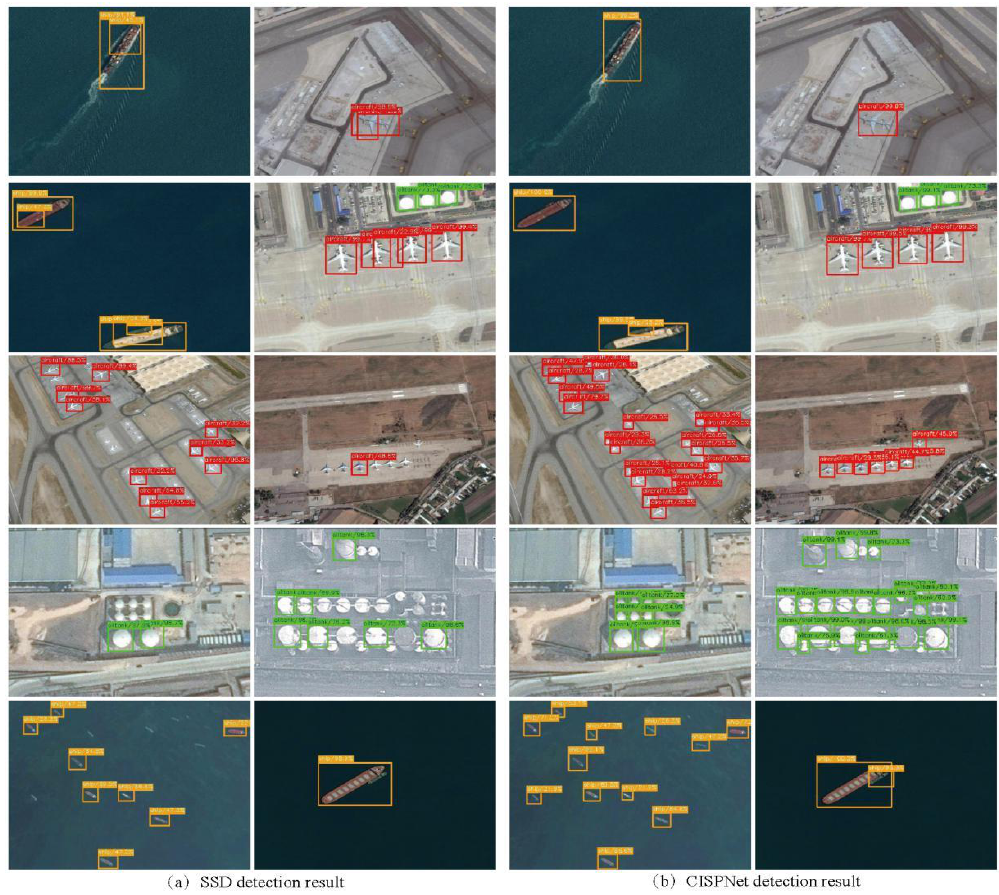
Figure 8. Detection examples on the remote sensing image test dataset with SSD / CISPNet model. ( a ) The results of the SSD. ( b ) The results of CISPNet.